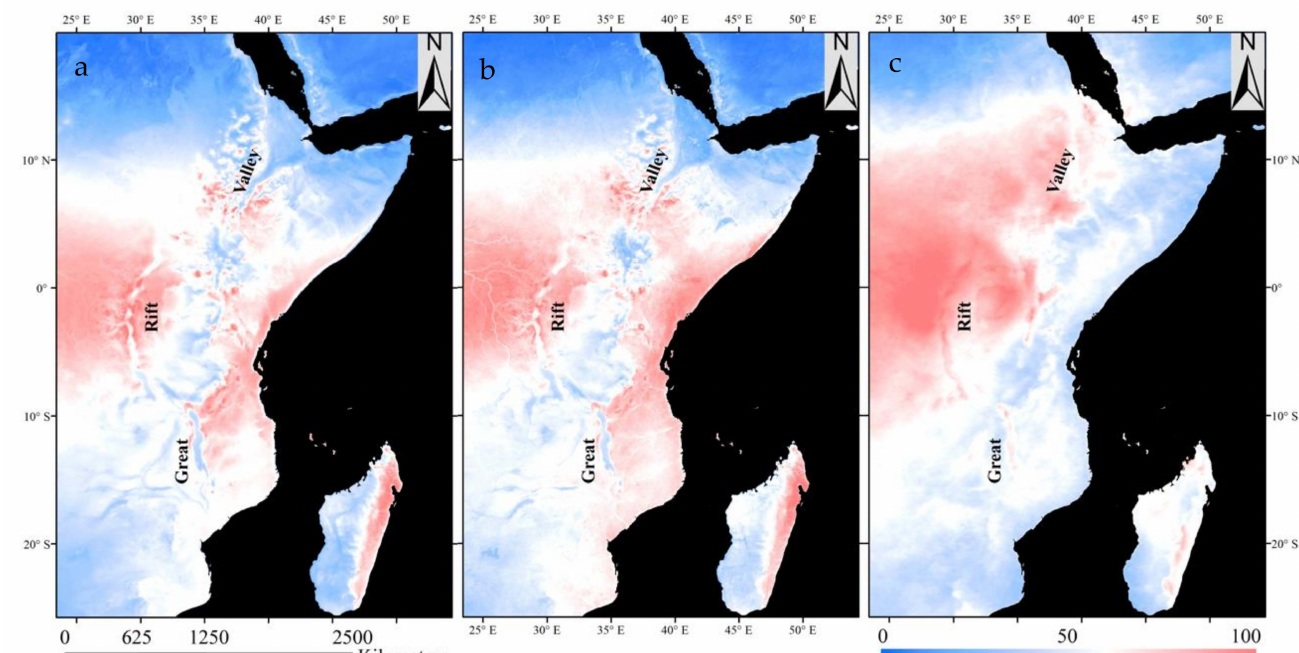
Figure 25. Cloud frequency (%) of East Africa in 2010 of GLHCC ( a ), MOD/MYD35 ( b ), and PATMOS-X ( c ).